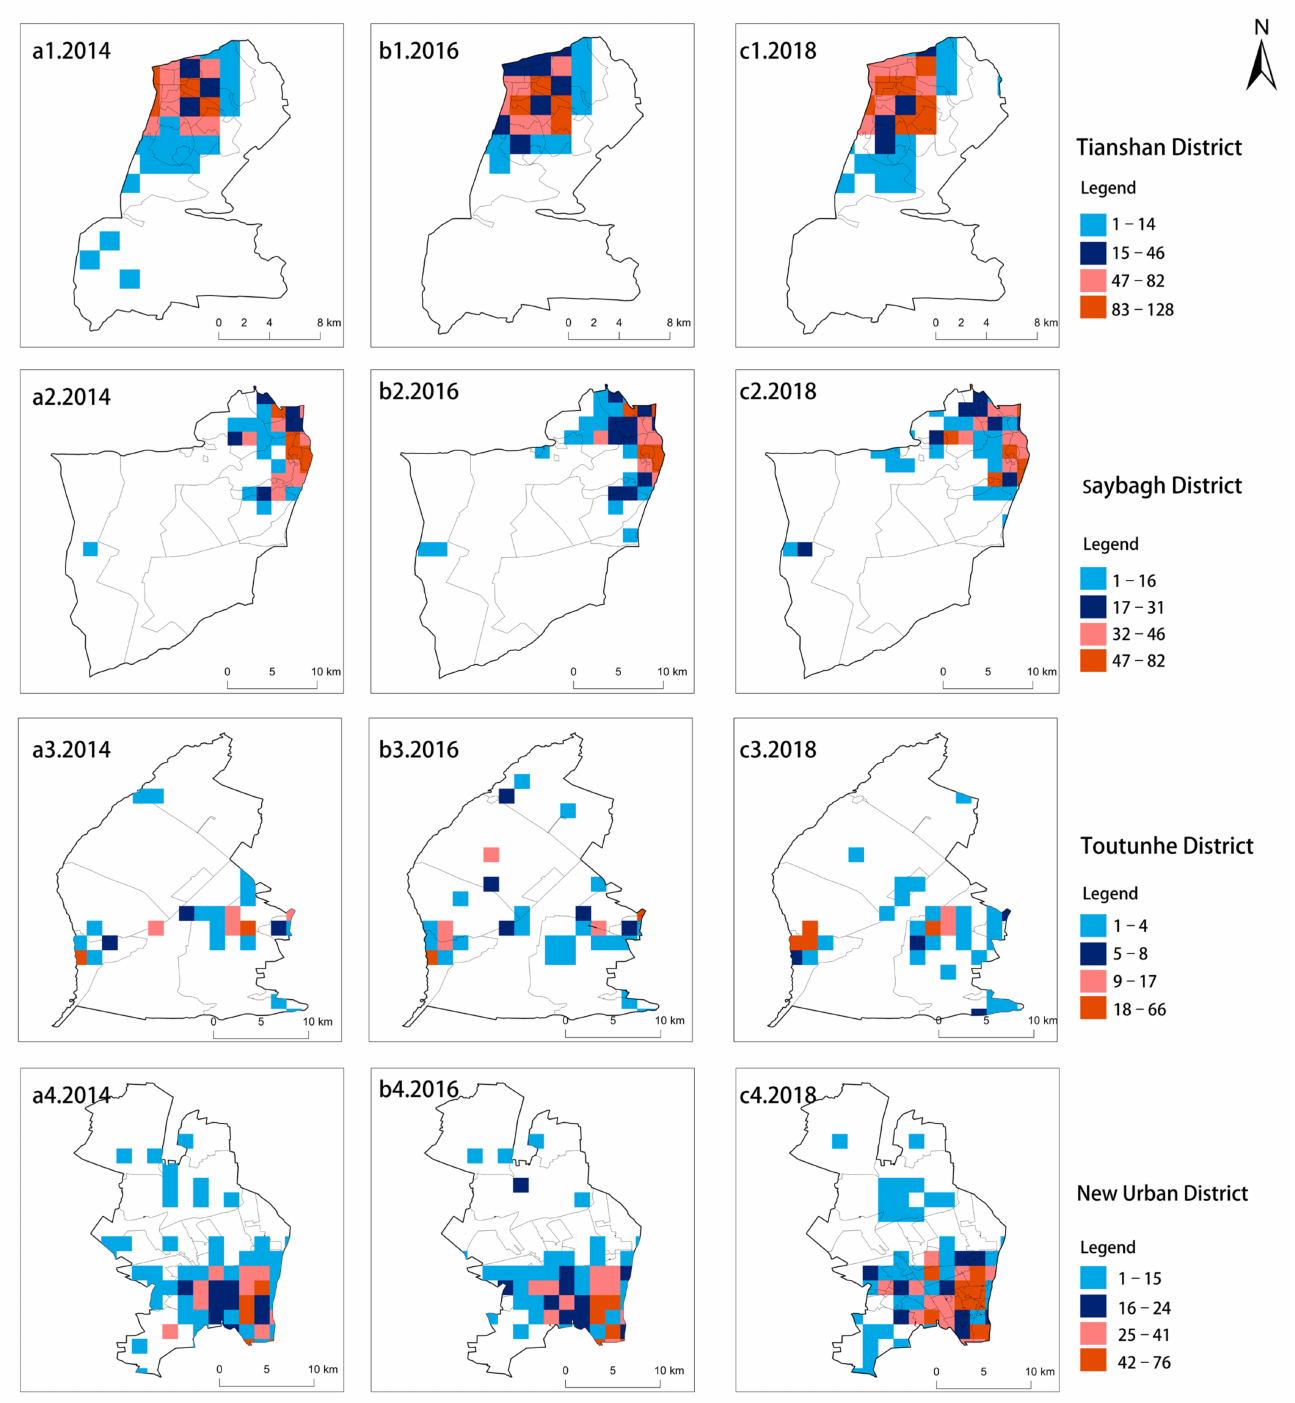
Figure 3. High-density HFMD districts in Urumqi from 2014 to 2018—( a1 – a4 ). 2014, ( b1 – b4 ). 2016, ( c1 – c4 ).